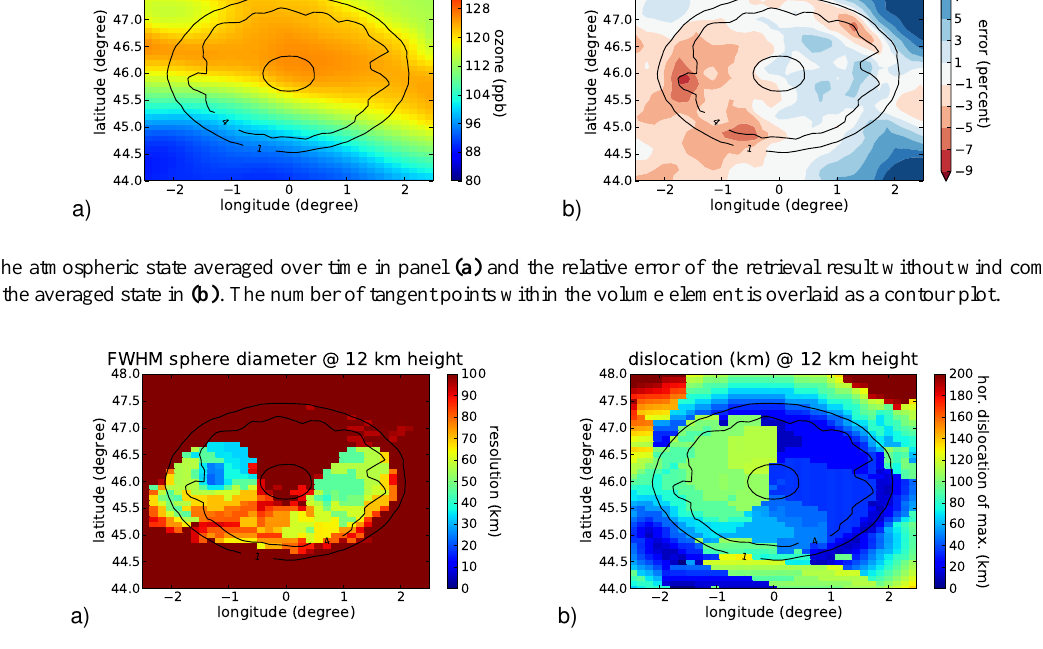
Fig. 17. The resolution of the retrieval without a priori wind speed information related to the atmo- spheric state prevalent during the first measurement. The left panel (a) shows the FWHM sphere di- ameter. Panel (b) shows the distance between the shown data element and the element with the largest contribution in the associated row of the averaging kernel matrix. The number of tangent points within the depicted volume elements is overlaid as a contour plot.